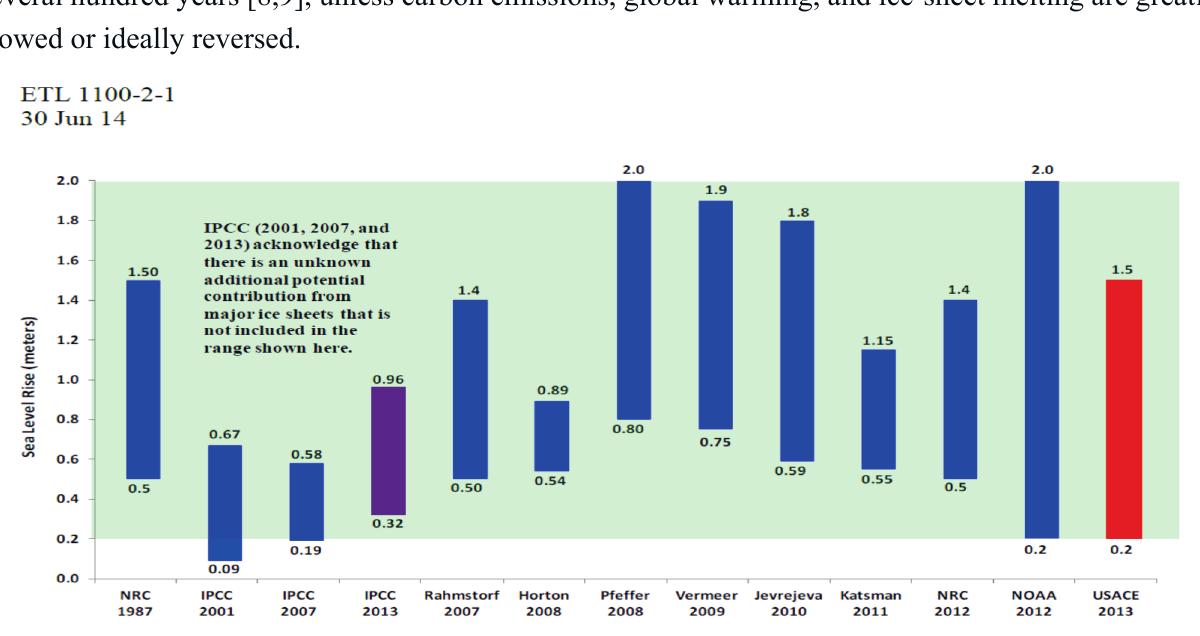
Figure 2. Comparison of maximum and minimum estimates of global sea level rise by